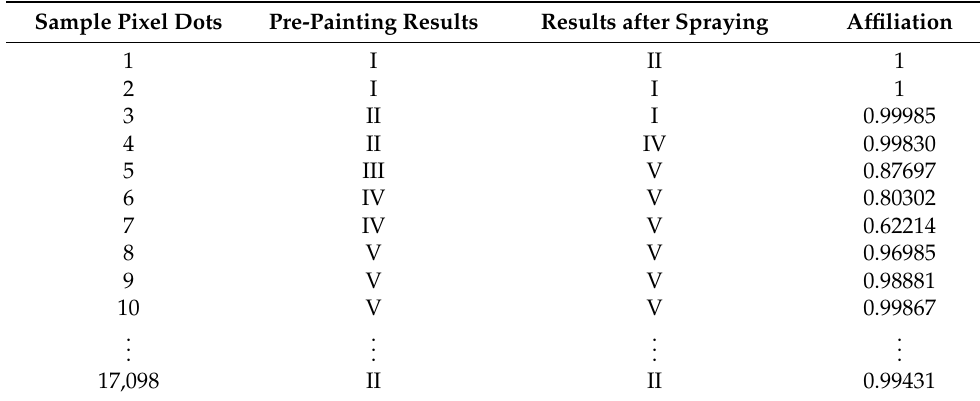
Table 5. Concrete surface pixel point clustering results before and after silane